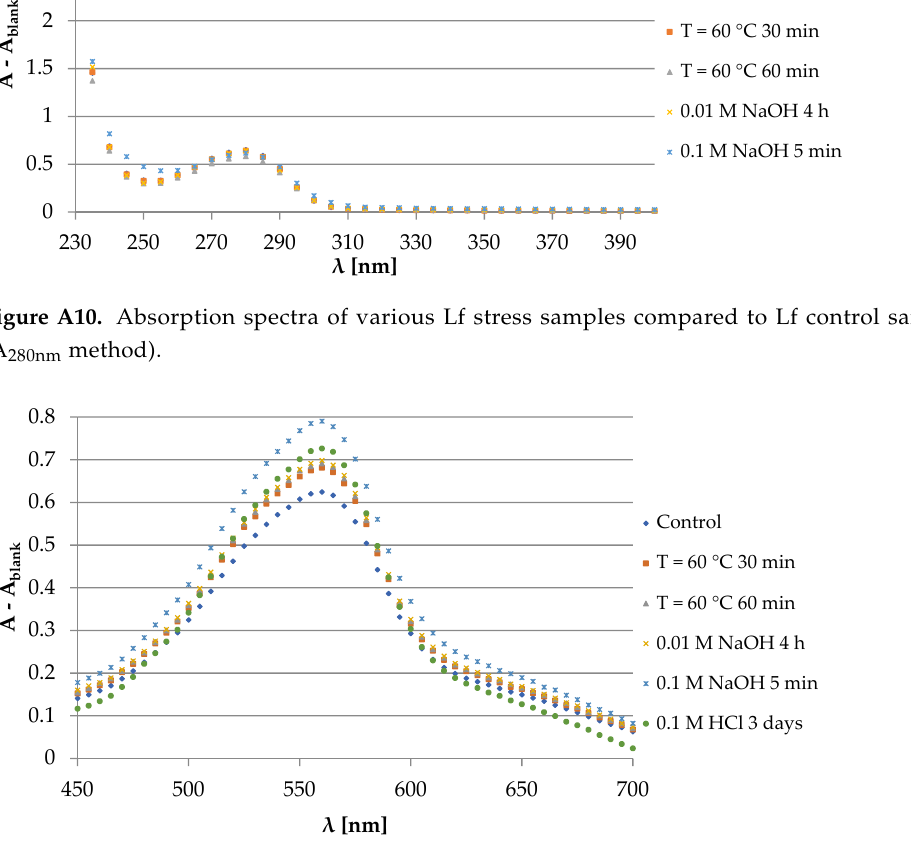
Figure A12. Emission spectra of various Lf stress samples compared to Lf control sample (FLD method).